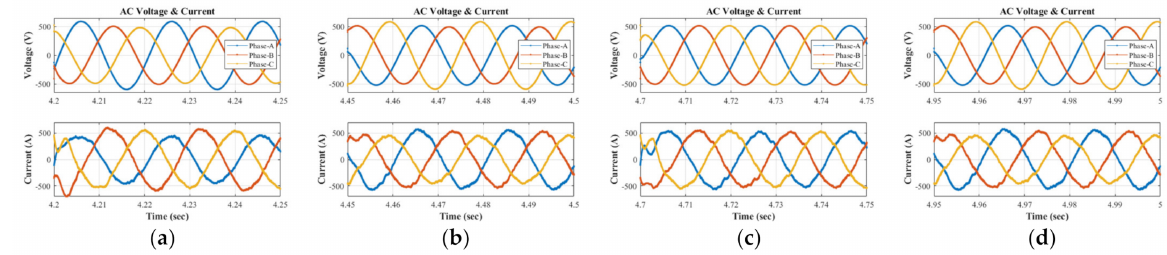
Figure 7. 3–phase AC faults; ( a ) 1 line–ground, ( b ) 2 line–ground, ( c ) 3 line–ground and ( d ) line–line.